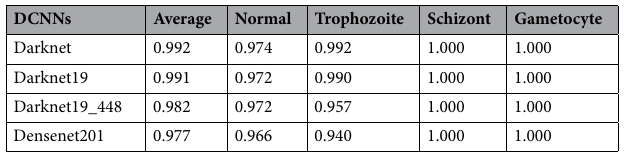
Table 2. Model-wise comparison and multiclass-wise comparison based on the sensitivity from one-class versus total.